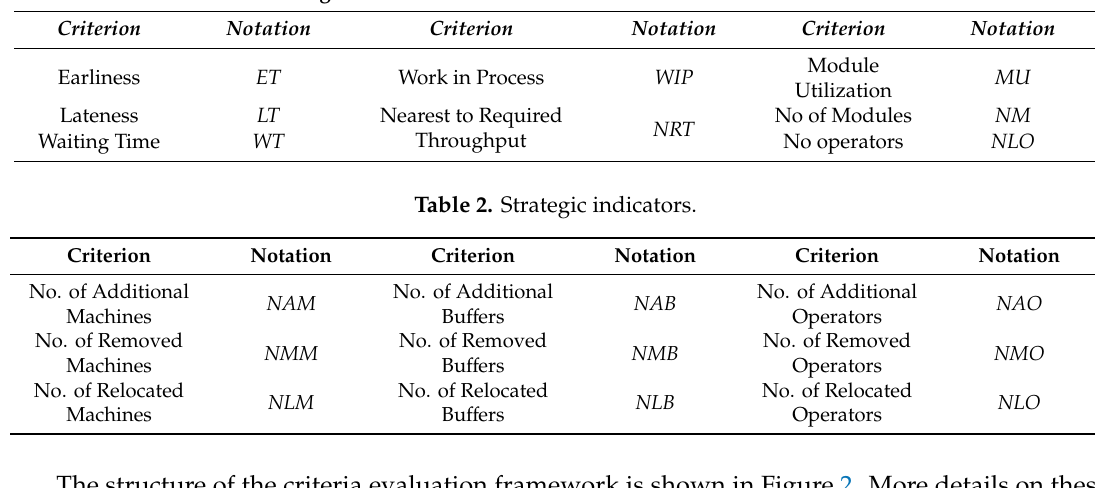
Table 1. Operational criteria.